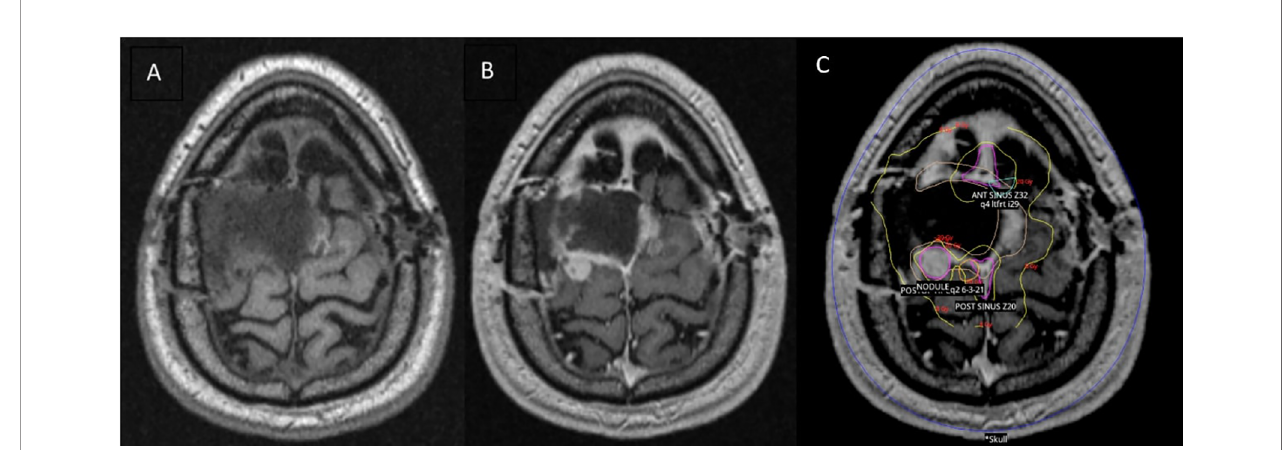
FIGURE 2 | Brain MRI performed 44 days post-operatively and overlying radiotherapy treatment plan. (A) MRI T1 pre-contrast. (B) MRI T1 post-contrast showing peripheral nodular enhancement on the left lateral and posterior surgical bed. (C) Gamma Knife (GK) radiosurgery treatment plan overlying T1 post-contrast MRI brain. The wide post-operative area is represented by the yellow contour. The pink contours delineate the three nodular, high-risk